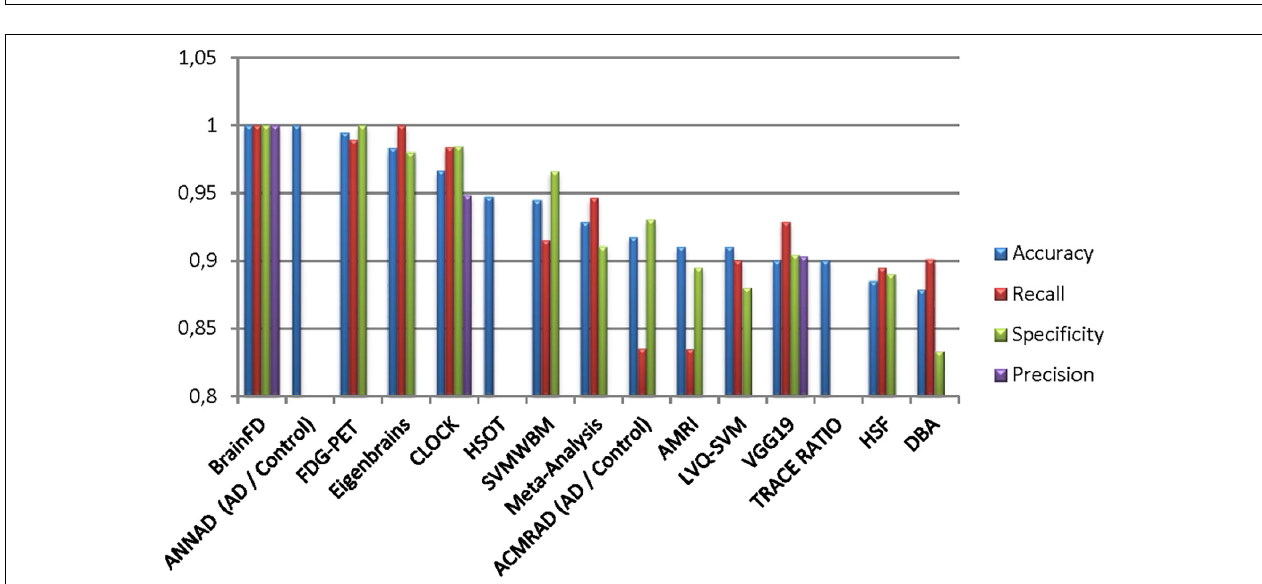
FIGURE 19 | The Fbeta score, recall, and precision metrics of the classifications performed in each brain region.